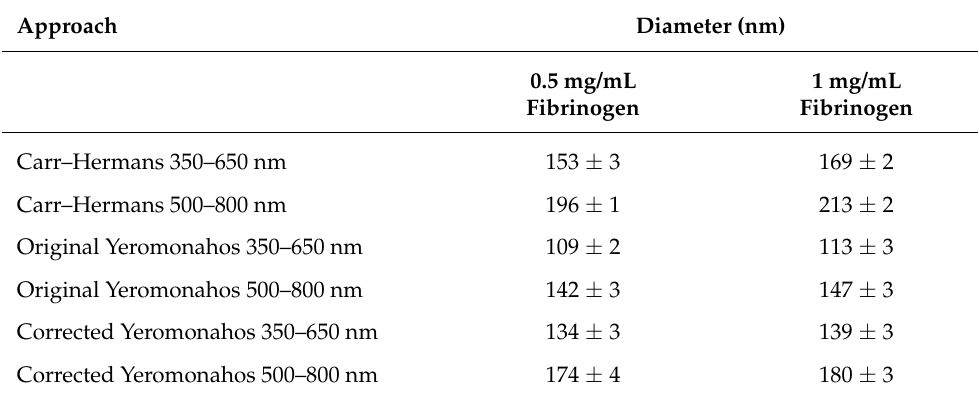
Table 2. Diameter values and uncertainty obtained by (A) fitting experimental data with the three turbidimetric approaches with the wavelength dependence of n and dn/dc accounted for, and (B) using constant values of n and dn/dc, and (C) using super-resolution fluorescence imaging for clots formed from 0.5 mg/mL fibrinogen and 0.1 NIH-U/mL thrombin in HBS buffer + 5 mM calcium chloride (middle column), and clots formed from 1 mg/mL fibrinogen, 0.1 NIH-U/mL